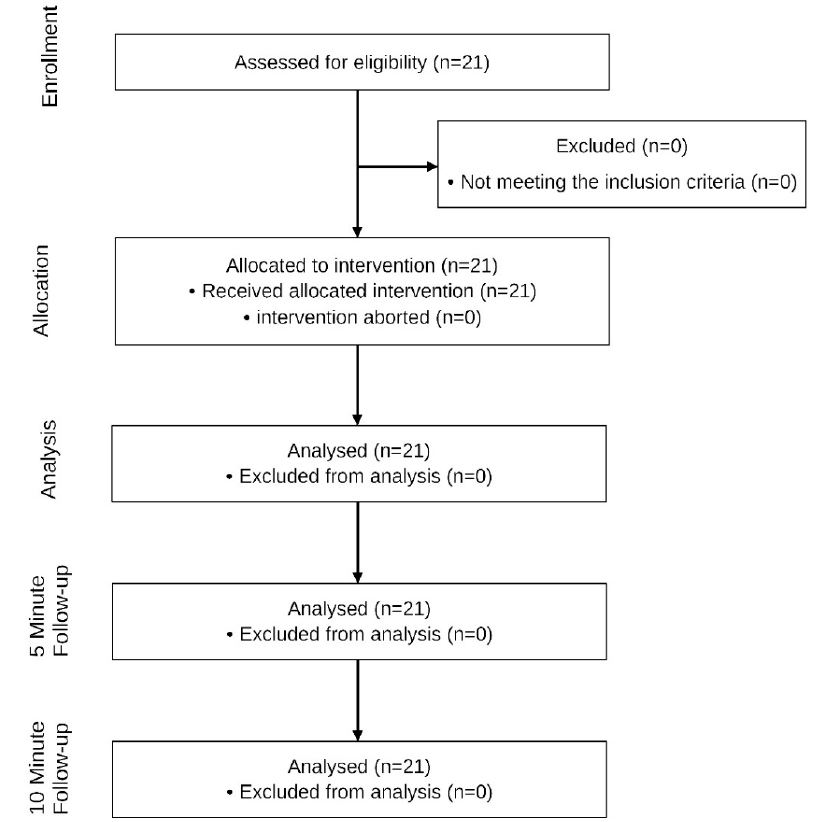
Figure 4. Flow chart of the study. Table 2. Bioimpedance analysis.